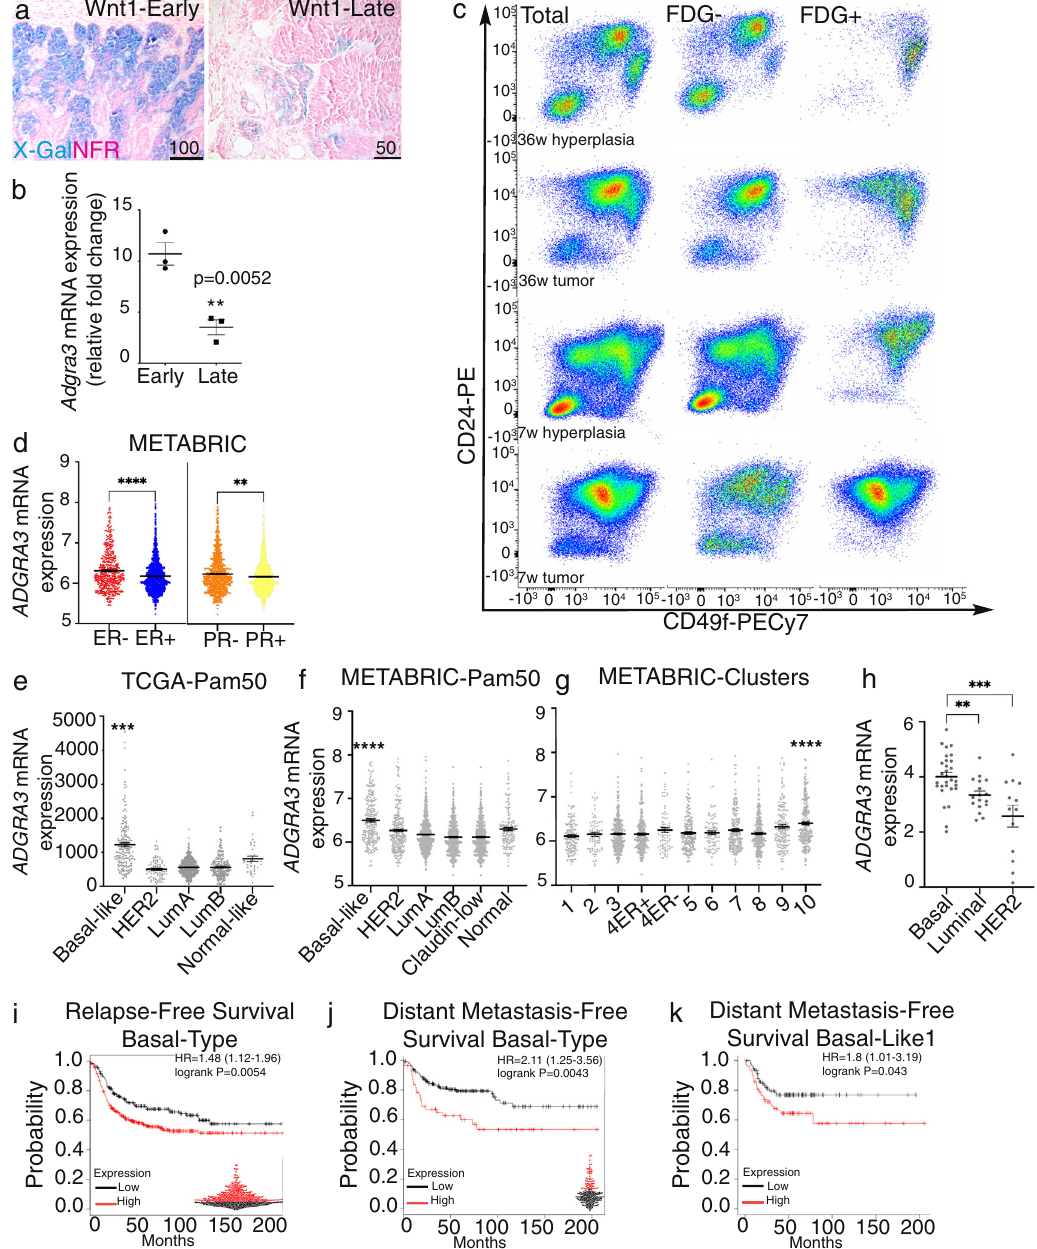
Fig. 7 High Gpr125 expression is predictive of poor outcome. a X-gal/NFR stained sections showing higher Gpr125- β -gal expression in a short (7w) latency MMTV-Wnt1;Adgra3 lz/ + tumor (Wnt1-early) versus a long (36w) latency (Wnt1-late) tumor. Scale bar 100 µ m and 50 µ m. ( n = 5 tumors/subtype). b qRT-PCR analysis of relative Adgra3 mRNA expression in early and long latency tumors MMTV-Wnt1;Adgra3 lz/ + tumors ( n = 3 tumors/subtype, ** p = 0.0052). c Representative FACS dot plots of total MECs isolated from MMTV-Wnt1;Adgra3 lz/ + hyperplastic uninvolved glands and associated short and long latency tumors stained with CD24 and CD49f. FDG + cells in: 36w tumor = 13331; 36w hyperplasia = 4048; 7w tumor = 64889; 7w hyperplasia = 13156. Plots are representative of three independent experiments. d ADGRA3 expression in (left) ER- ( n = 445) and ER + ( n = 1459) and in (right) PR- (n-895) and PR + ( n = 1009) BC patient samples from the METABRIC dataset ** p = 0.0042, **** p < 0.0001. e , f ADGRA3 expression in BC patient samples from TGCA PanCancer Atlas ( n = 1084) ( e ) and METABRIC ( n = 2509) ( f ) datasets classi fi ed using the PAM50 geneset; ****p < 0.0001. g Integrative clusters within the METABRIC dataset showing high ADGRA3 expression levels in cluster 10; **** p < 0.0001, Mann – Whitney test two tailed. h ADGRA3 expression in human breast cancer cell line from Depmap database (https://depmap.org/portal/) ** p = 0.0068, ***p = 0.0002, Unpaired t test two-tailed. i – k Kaplan – Meyer curves depicting ‘ Relapse-free survival ’ and ‘ Distant Metastasis-Free Survival ’ in months for high (red lines) and low (black lines) ADGRA3 mRNA expressing human basal-type ( h , i ) and basal-like-1 TNBC ( j ) breast cancer subtypes. Auto best fi t cutoff was used to divide patients into high and low expression (indicated in beehive plots) sourced from (https://kmplot.com/analysis/index.php?p = service&cancer = breast) KMplotter 75 . logrank p-value and Hazard Ratio (HR) indicate a signi fi cant association between high expression and poor prognosis. Each scatter dot plot represents the mean ± SEM. Source data for this fi gure are provided as a Source Data fi le.